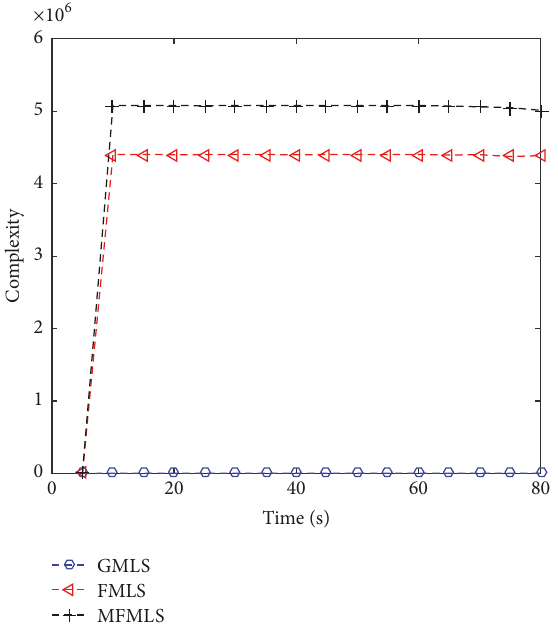
Figure 3: Computational complexity by different algorithms with high MSE thresholds.